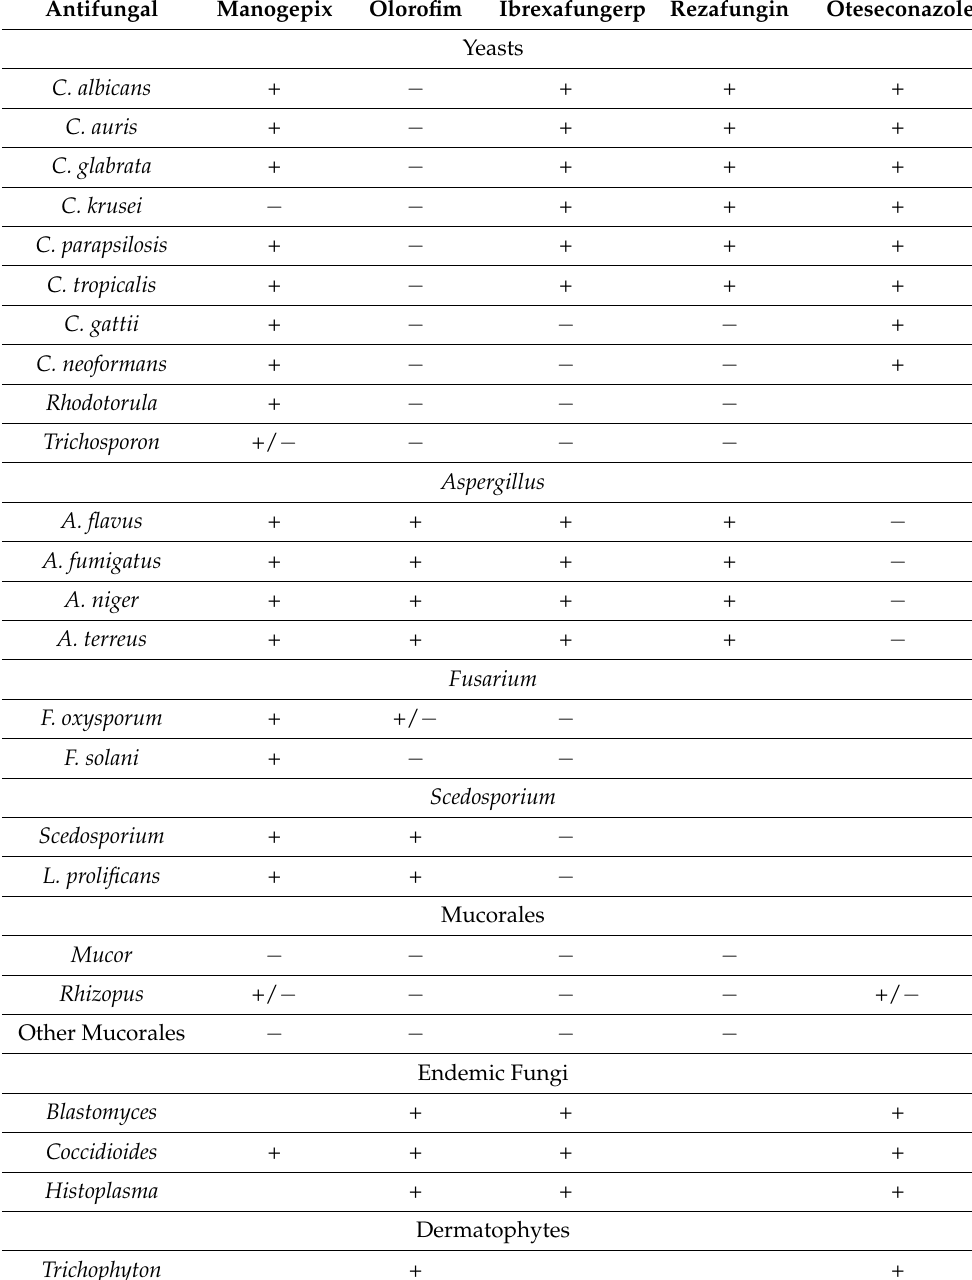
Table 2. In vitro spectrum of activity of antifungals currently under late-stage clinical development, including manogepix, olorofim, ibrexafungerp, rezafungin, and oteseconazole. + = in vitro antifungal activity observed; − = no in vitro activitiy; blank cells =